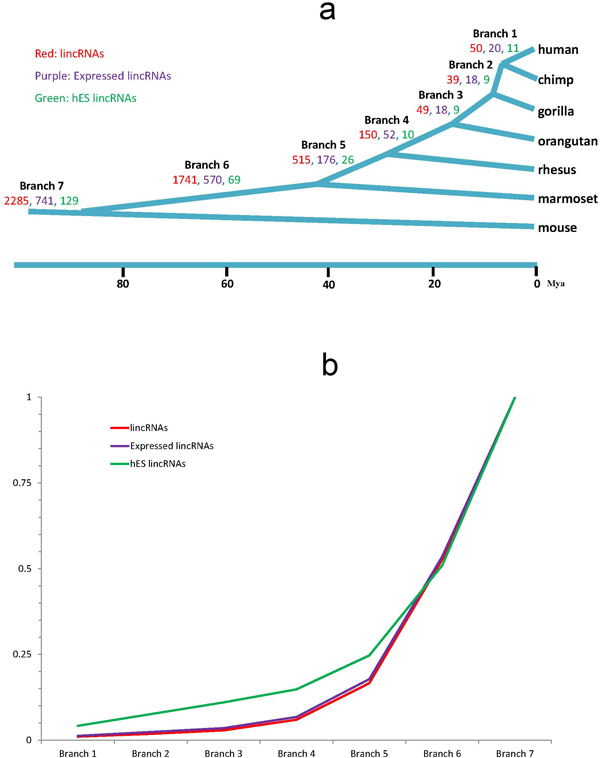
Evolutionary dating of lincRNAs. (a) The counts of lincRNAs originated from each branch (Red: all lincRNAs; Purple: expressed lincRNAs; Green: hES lincRNAs). (b) Cumulative distribution of age distributions of the three lincRNA gene sets.